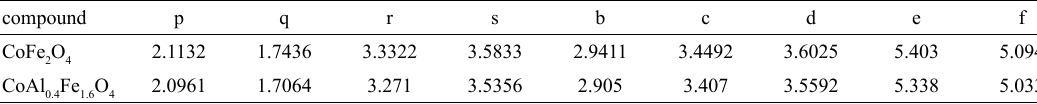
Table 4. Inter-ionic distances [A o ], of Al-Co-Fe-O system compound